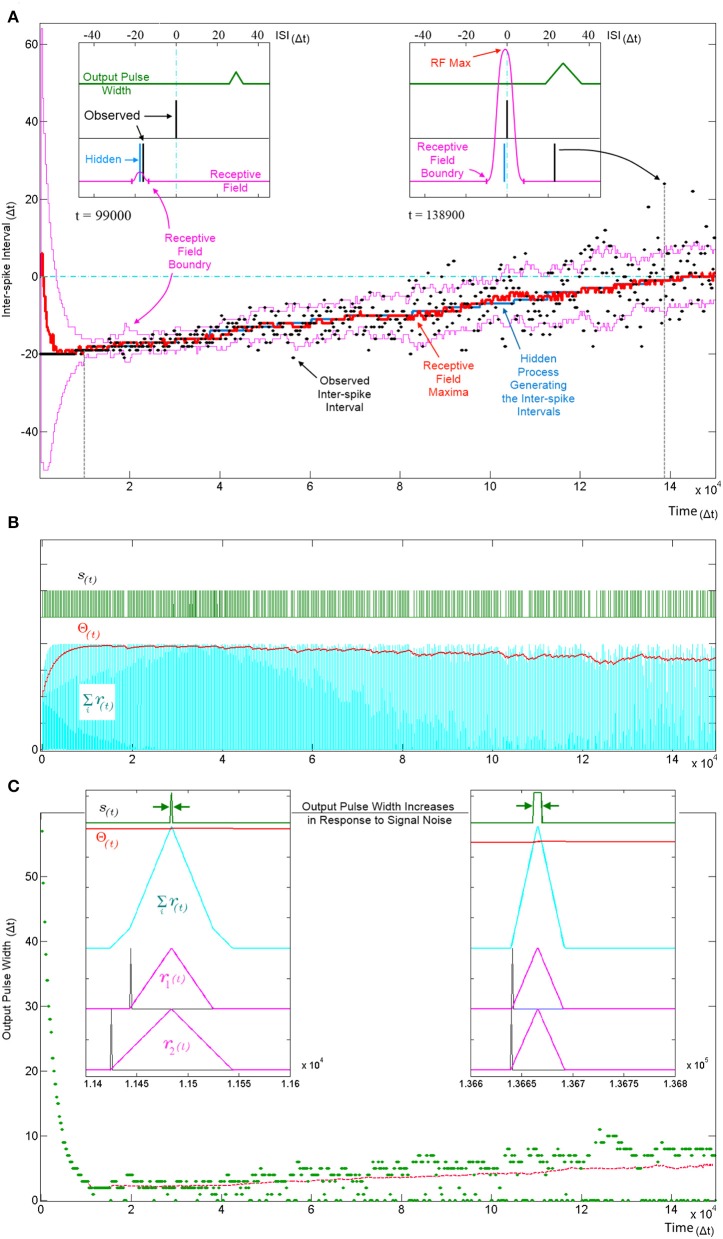
Tracking a hidden ISI producing process and its variance. All three panels (A–C) show different aspects of the same simulation where a single SKAN learns statistics of a dynamic ISI across two input channels. (A) A hidden process (blue) moves from ISI = −20 Δt to ISI = 0 Δt. The process begins with no temporal jitter noise, such that the observed ISI's (black dots) equal the hidden process (σ = 0 Δt) and the blue hidden process is covered by the observed black dots. At t = 0, the sum of the neuron's randomly initialized kernels peak at ISI = 6 Δt. As the kernels adapt and capture the ISI information, the receptive field maximum (red line) converges on to the observed ISIs. This causes the threshold to rise shrinking the receptive field to a minimum size (left inset t = 9.9 kΔt). At this stage receptive field boundaries (pink lines) lie very close on either side of the hidden process' mean value. As the simulation continues the noise in the ISI producing process is deliberately increased linearly with time. The neuron continues to follow the process but with every spike that doesn't land on the receptive field maximum the threshold falls slightly which increases the receptive field size and increases the neuron's receptivity to ever more unlikely observations (right inset t = 138.9 kΔt). (B) Variables and behavior of the neuron throughout the simulation: after a rapid initial increase the threshold Θ(t) settles near the peak of the membrane potential Σri(t). As the noise increases linearly the threshold begins to fall gradually. Missing output spikes in the s(t) spike train correspond to input spikes that have landed outside the receptive field boundaries. (C) The output pulse width (green = observed, red = running average) increases with increasing signal noise. As with the receptive field size, the output pulse width is initially large. As more patterns are observed, the threshold rises and settles just below the peak of the membrane potential and the pulse width reaches a minimum width of 1–2 Δt. At this low noise level (σ ≈ 0.5 Δt) there are no missing outputs, such that all pulse widths are above zero. As the noise increases, more ISIs land away from the receptive field maximum and some fall completely outside the receptive field, decreasing the threshold, which results in wider output pulse width whenever observed ISI's do land near the receptive field maximum. The dashed magenta line tracks the mean spike width, which also increases with noise. This illustrates that the mean output pulse width of SKAN is a reliable correlate of input noise level.